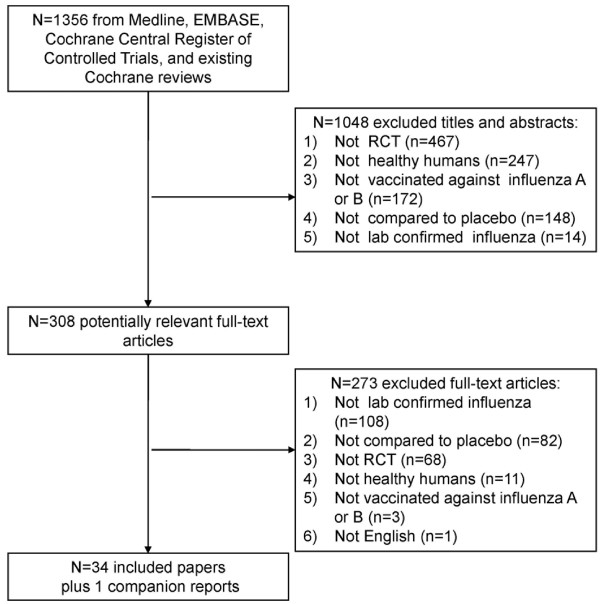
Study flow. This figure displays the flow of titles/abstracts and full-text studies through the systematic review.